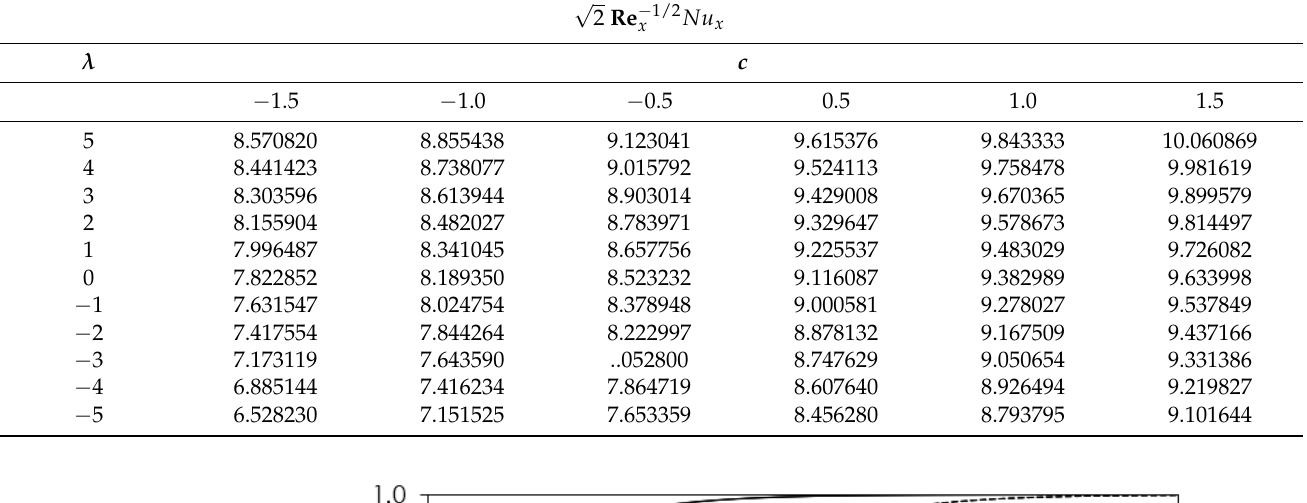
√ Table 5. 2 Re − 1/2 x Nu x values for various values of c .